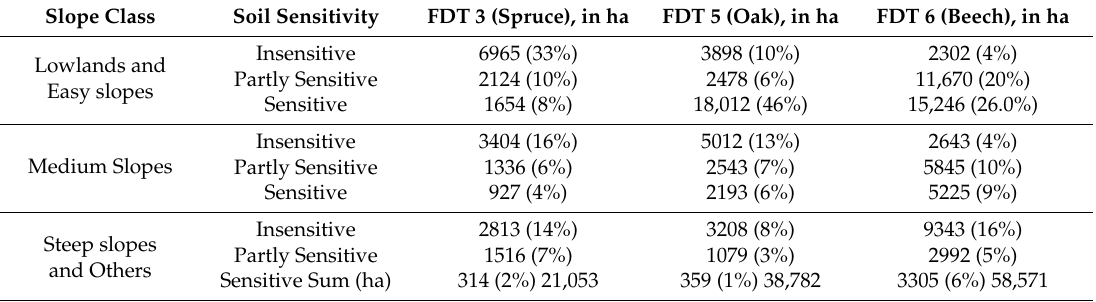
Table 5. Distribution of slope and soil sensitivity classes for three Forest Development Types: Risk reduced spruce forests (FDT 3), oak-mixed forests (FDT 5), and beech-broadleaved-mixed forests (FDT 6), in ha and %. The percentages are related to the area of each FDT respectively. Figure 5. Distribution of the analyzed forest area with regard to topography and soil sensitivity to traffic (light grey: insensitive, dark grey: partly sensitive and black: sensitive), as a percentage of total forest area.